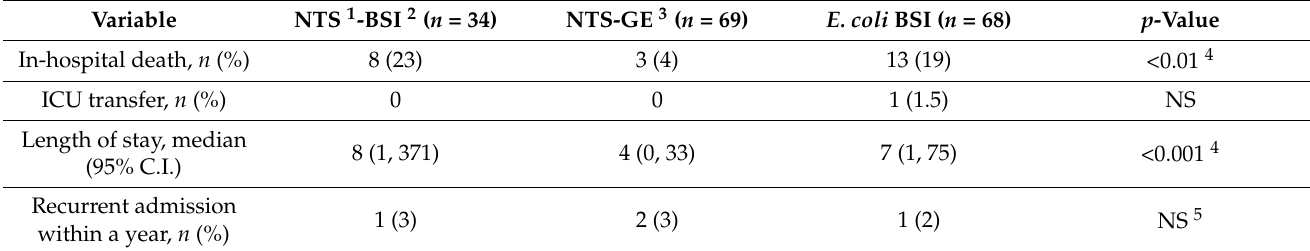
Table 3. Outcome measures of patients in all three